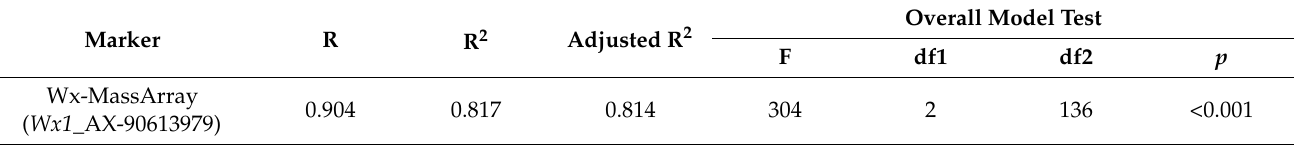
Figure 5. MassArray marker associated with amylose trait developed based on the SNP in Wx1 . ( A ) Allelic discrimination plot of the marker Wx-MassArray validated in panel of 139 maize lines with different amylose content. Scatter dots with different colors show clustering of homozygous genotype GG (brown), heterozygous genotype CG (green), and homozygous genotype CC (blue). ( B ) Violin plots with box plots showing the average % amylose content of maize lines correlated with the results of allelic discrimination of the MassArray marker. Paired t -tests, violin plots, and box plots were obtained using SRplot (http://www.bioinformatics.com.cn; accessed on 27 August 2022). Table 3. Test of marker–trait association between the Wx-MassArray marker and amylose content in 139 maize